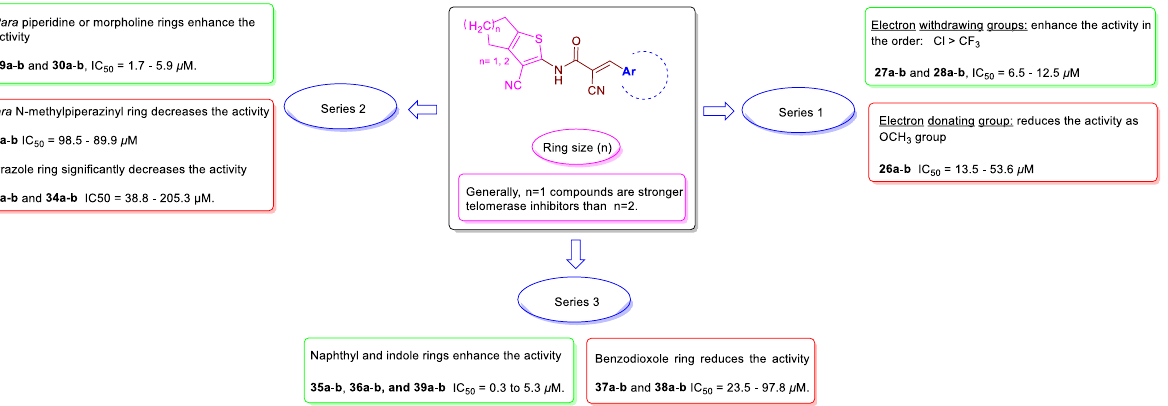
Figure 11. Structure – activity relationship summary for compounds 25a – 39b as telomerase inhibitors.